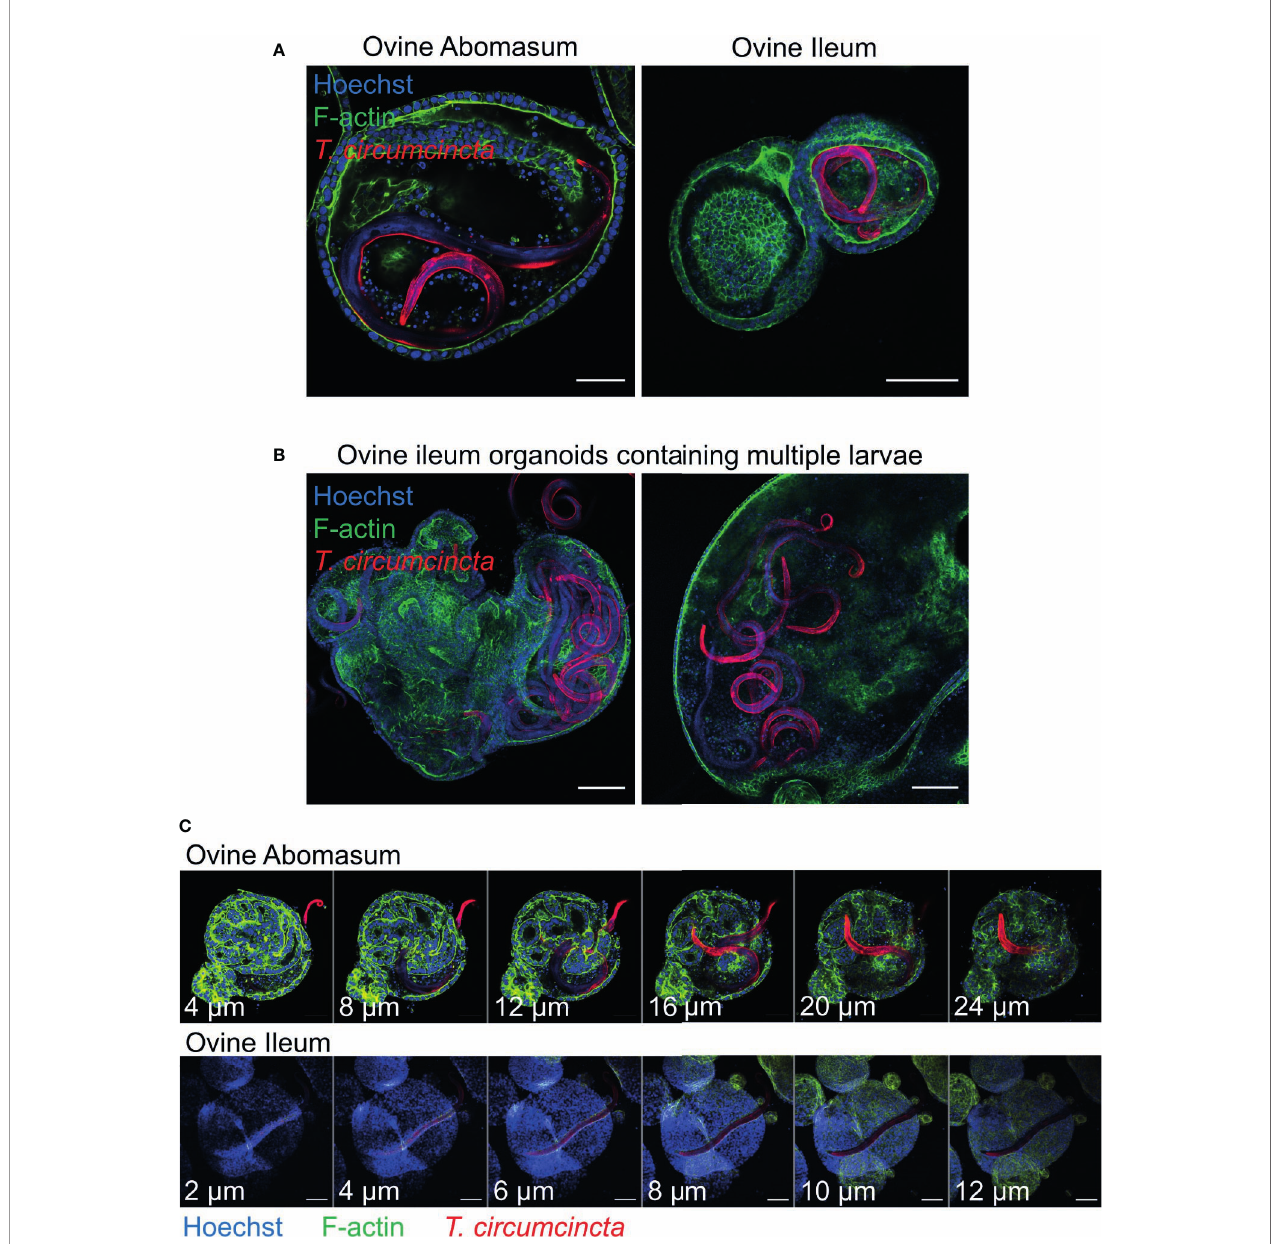
FIGURE 9 | Ovine gastric and intestinal organoids modelling a helminth infection. (A) Representative images of ovine abomasum and ileum organoids challenged with the helminth parasite Teladorsagia circumcincta . Following 24 hours of co-culture, L3 stage T. circumcincta (red) are visible within the lumen of abomasum and ileum organoids. (B) Representative images of individual ileum organoids presenting an enlarged lumen containing multiple worms (red). (C) Representative Z-stack images showing L3 stage T. circumcincta (red) migrating through the epithelial layer in abomasum and ileum organoids. F-actin (green) and Hoescht (blue). Scale bars = 10